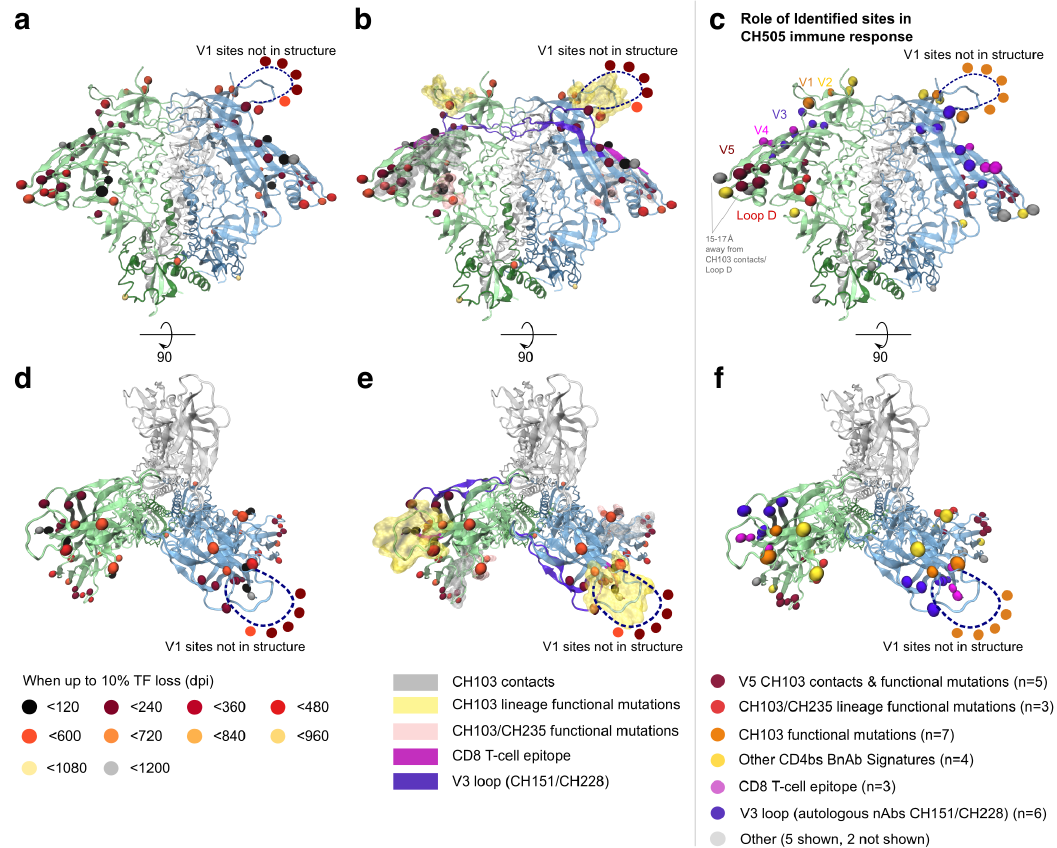
Figure 4. Selected sites are localized to the known immunogenic regions in CH505, as visualized by mapping onto the structure of the engineered BG505 SOSIP trimer (Protein Data Bank ID 4TVP [48]). Selected sites are depicted as spheres, colored to indicate the timing of their emergence. ( a ) Side view, oriented with viral membrane towards bottom; ( b ) Additional colored highlights indicate known immunogenic regions; ( c ) Selected sites are colored to show which immune pressures are known to have induced TF loss; ( d – f ) The corresponding details from top view, as seen from host cell membrane. Table 1 lists symbol colors for each selected